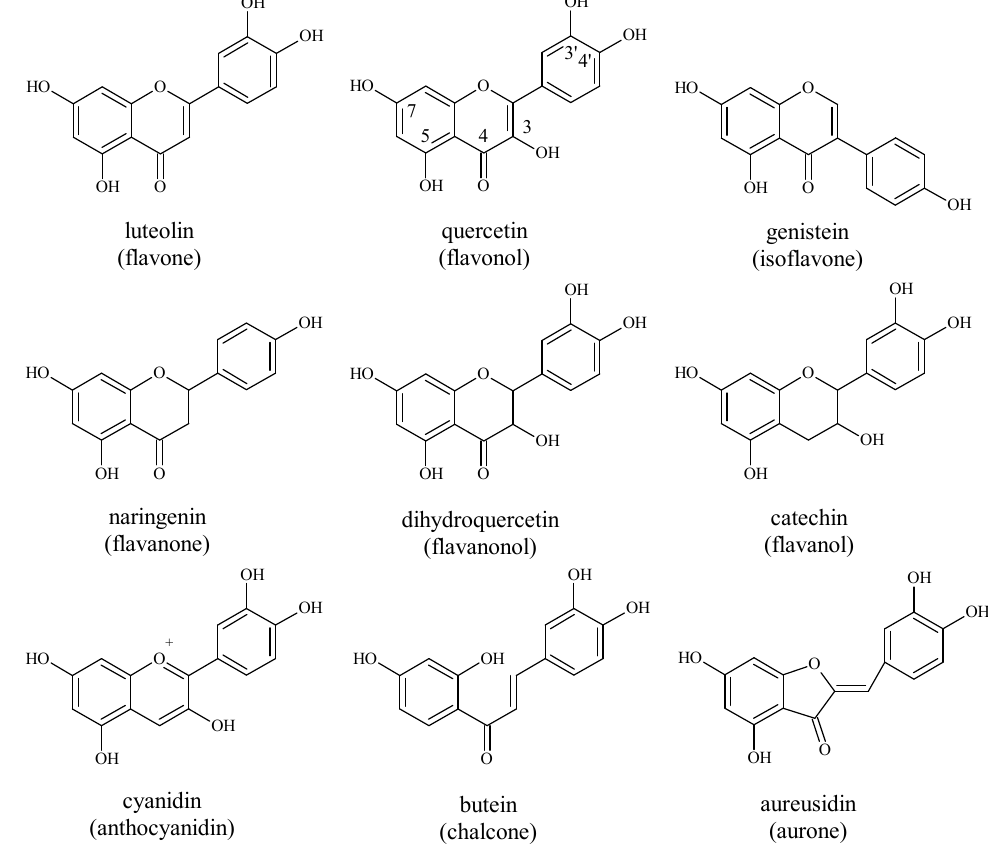
Figure 4. Structure of some classes of flavonoids.